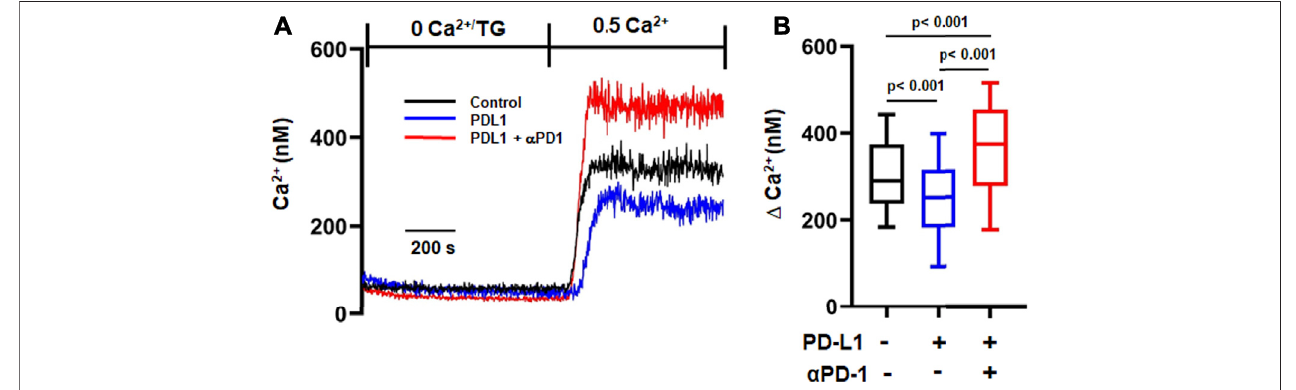
FIGURE 4 | α PD-1 rescues the reduced Ca 2+ in fl ux induced by PDL-1-Fc in HDs. (A) Representative traces of intracellular Ca 2+ response in activated CD8 + PBTs of HDs. Cells were loaded with Fura-2 and Ca 2+ fl uxes were elicited by TG/0 mM Ca 2+ followed by 0.5 mM Ca 2+ (See Material and Methods ). Cells were incubated with plate bound PD-L1 (PD-L1-Fc, 10 μ g/ml for 72 h) followed by treatment with α PD-1 (10 μ g/ml for 6 h). (B) Summary of Δ Ca 2+ values of activated CD8 + PBTs of HDs (n (cid:1) 160 – 255cellsfromnineHDs,20 – 50cellswererecordedfromasingleHD,see Methods ).ThevaluesinpanelBarerepresented asboxand whiskerplots.The lowerandupperboundoftheboxrepresent25 th and75 th percentilesrespectively.Medianvaluesareshownashorizontalline.Theloweranduppererrorbarsrepresents 10 th and 90 th percentile respectively. Data were analyzed using ANOVA ( p < 0.001) on ranks followed by Dunn ’ s post hoc